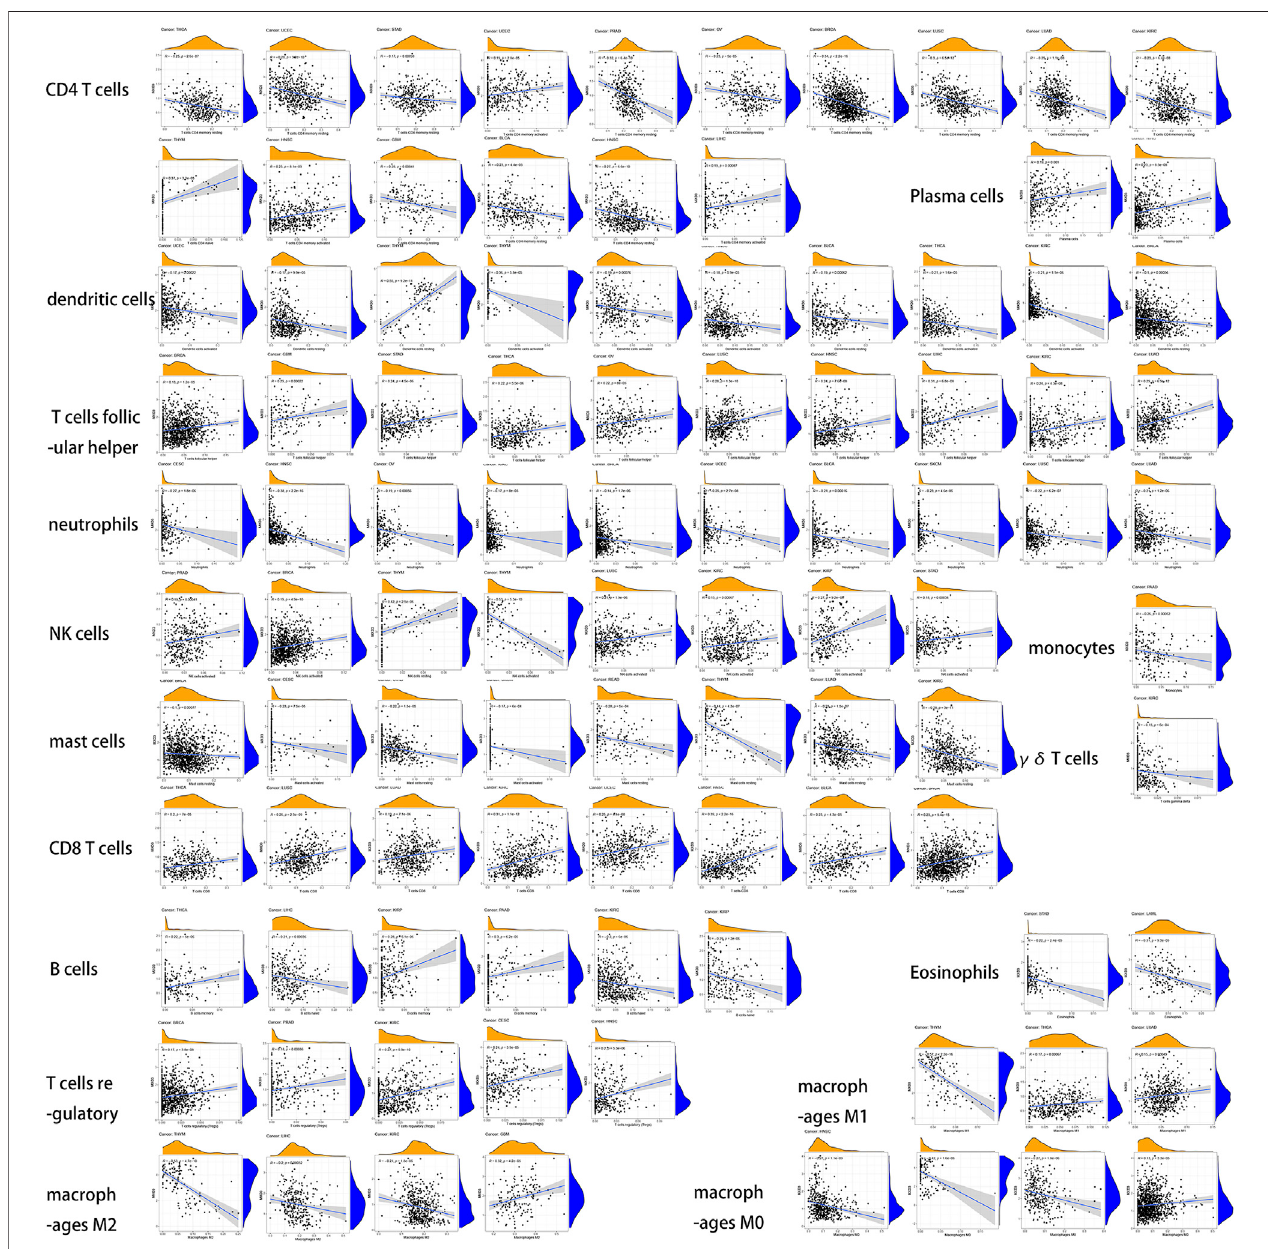
FIGURE 11 | Dependence analysis of MXD3 expression on in fi ltrating immune cells in different types of cancers.